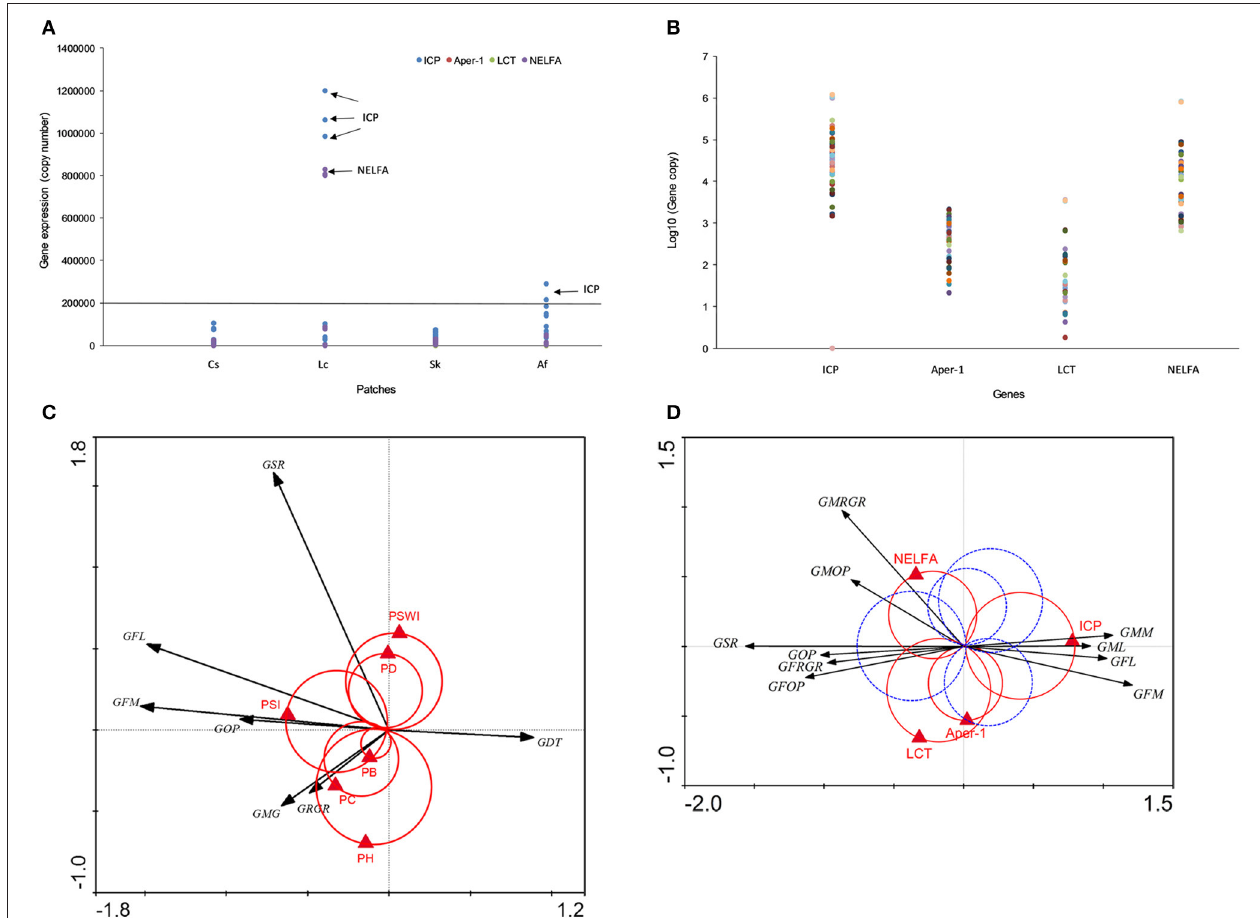
FIGURE 4 | (A) Candidate gene expression across four populations detected by qPCR. (B) Four gene expression profiles are given. Different colored dots indicate sample individuals, sample size, N = 48. (C) The interaction between grasshopper performance and plant community. The black arrows indicate grasshopper performance, the red Van Dobben circles with the red triangles indicate plant community structure variables and their effects. (D) The interaction between grasshopper performance and genes. Black arrows indicate grasshopper performance and the triangles indicate specific genes. The grasshopper performance involved in one of the two color circles predicted to change their value with the changing value of that particular gene. Those preferring higher values of the performance variables are enclosed by the positive circle (red). Those with preference for low values of the corresponding performance variables are enclosed by the negative (mirror) circle (blue dash). GFM, grasshopper female mass; GRGR, grasshopper relative growth rate; GMG, grasshoppers’ mass gain; GFL, grasshopper female length; GDT, grasshopper development time; GSR, grasshopper survival rate; GOP, grasshopper overall performance; PSWI, plant Shannon-Wiener index; SI, plant selective index; PH, plant height; PD, plant density; PB, plant biomass; PC, plant coverage; Aper1, peritrophin-1; ICP, insect cuticle protein; NELFA, negative elongation factor A; LCT, lactase-phlorizin hydrolase. All genes were at q < 0.005, |log2.Fold_change| >